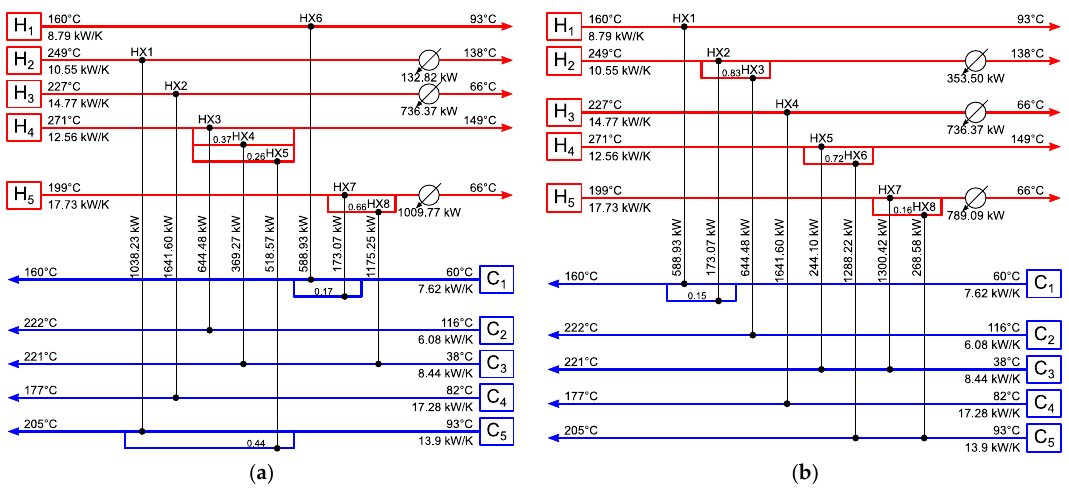
Figure 3. Grid-diagram representations of: ( a ) the optimal HEN configuration of example 1b (TAC: 68476 $/yr); and ( b ) an alternative HEN configuration of example 1b (TAC: 68843 $/yr). As opposed to the solution of example 1a only two stages within the superstructure are taken by heat exchangers. Furthermore, the number of utility heat exchangers increased to three compared to the case not considering piping. The results still represent MER networks. Figure 4 and Figure 5 show the relative orientation of the heat sources and heat sinks towards each other.